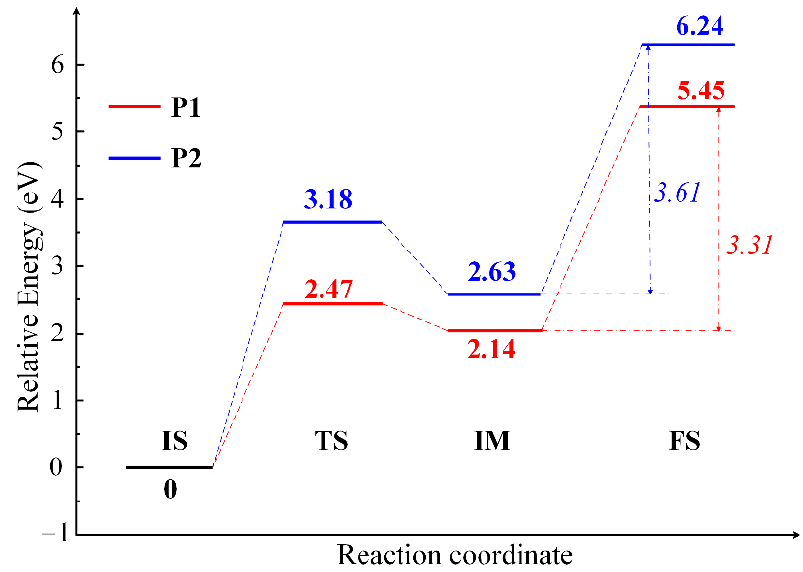
Figure 4. The initial state (IS), transition state (TS), intermediate state (IM), and final state (FS) struc- tures for the O 2 formation and O 2 desorption processes in different pathways on the CuO(111) sur- face. The bond lengths are presented in Å. The salmon pink and red spheres denote Cu and O atoms, respectively.